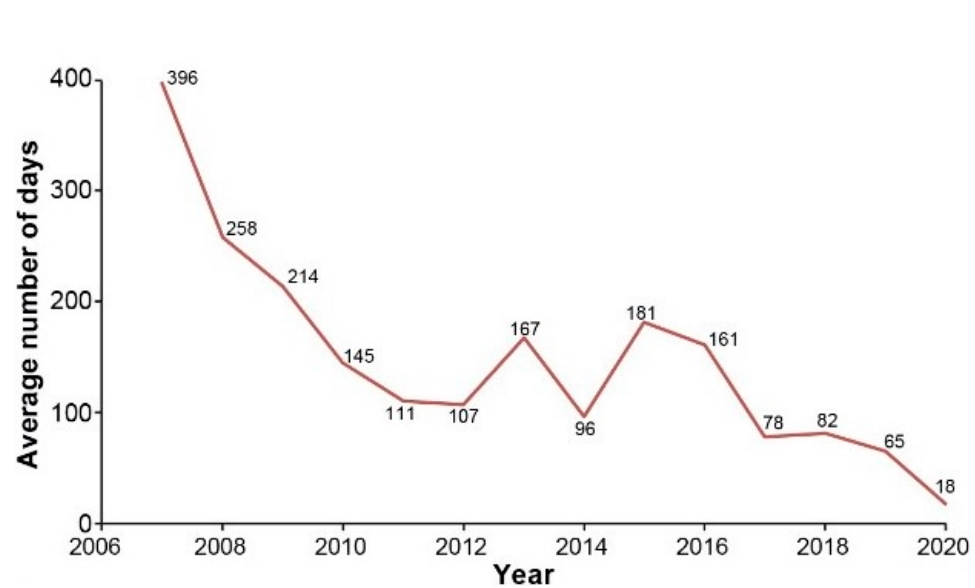
Figure 3. Average Number of Days between Counseling and Disclosure of Genetic Test Result Over Time.